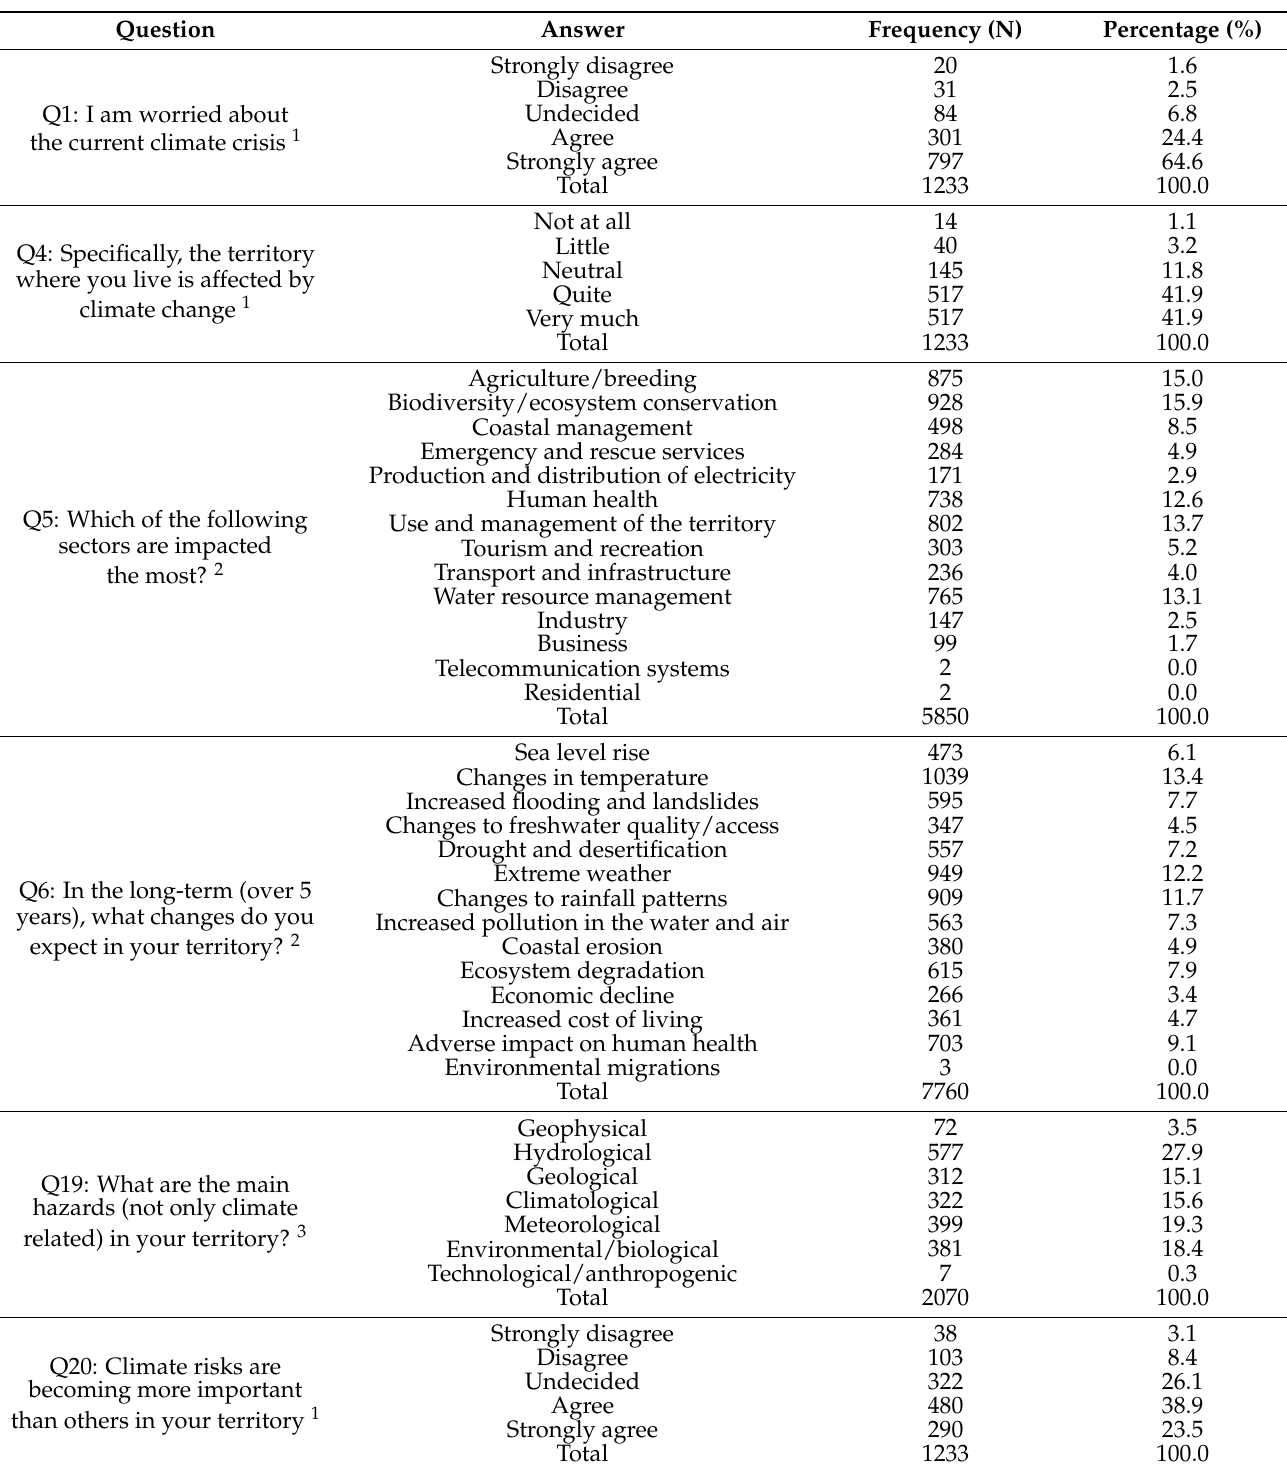
Table A2. Answers to the perception part of the questionnaires (sample size = 1233 individuals). For analytical purposes Q6 and Q19 were reclassified into fewer and broader